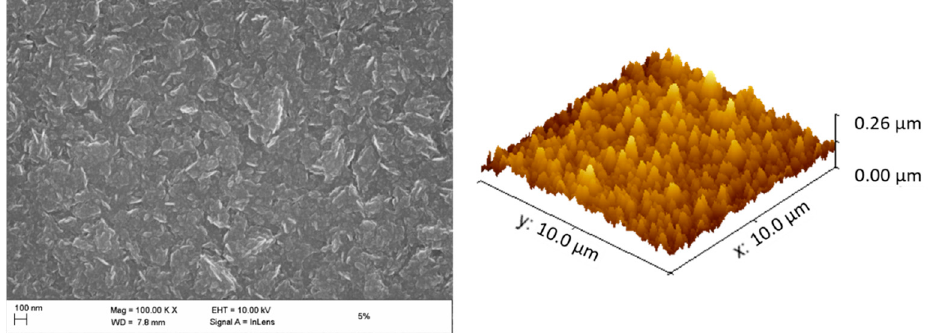
Figure 2. SEM and AFM images of diamond film sample Ⅲ with a methane ratio of 5% in the process gas.